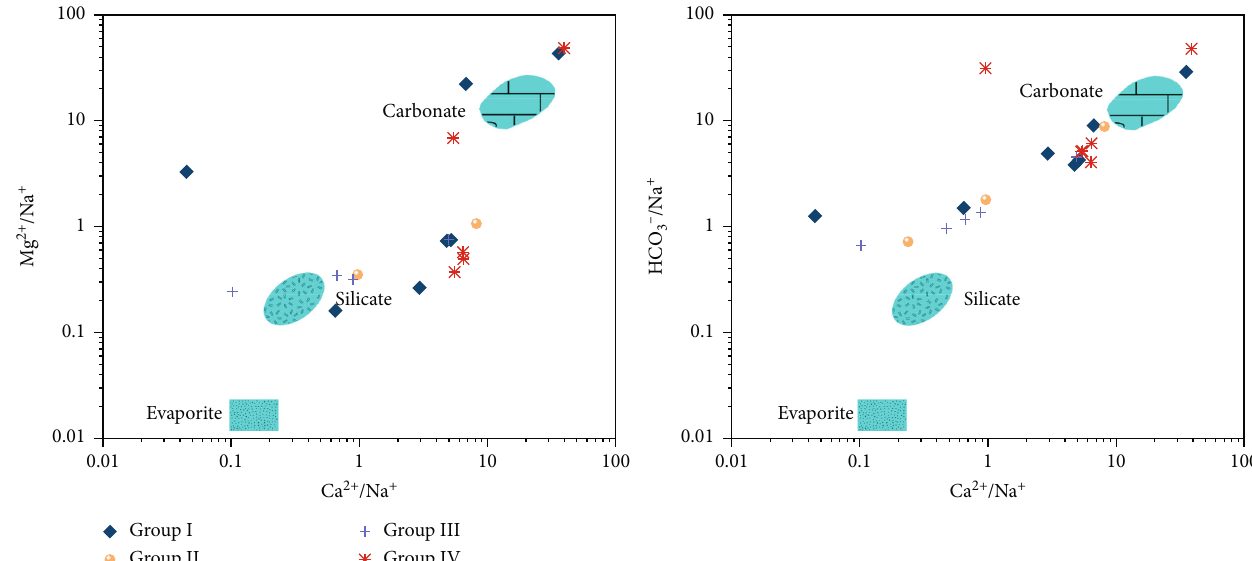
Figure 8: The ratio of Mg 2+ /Na + to Ca 2+ /Na + and HCO 3- /Na + to Ca 2+ /Na +